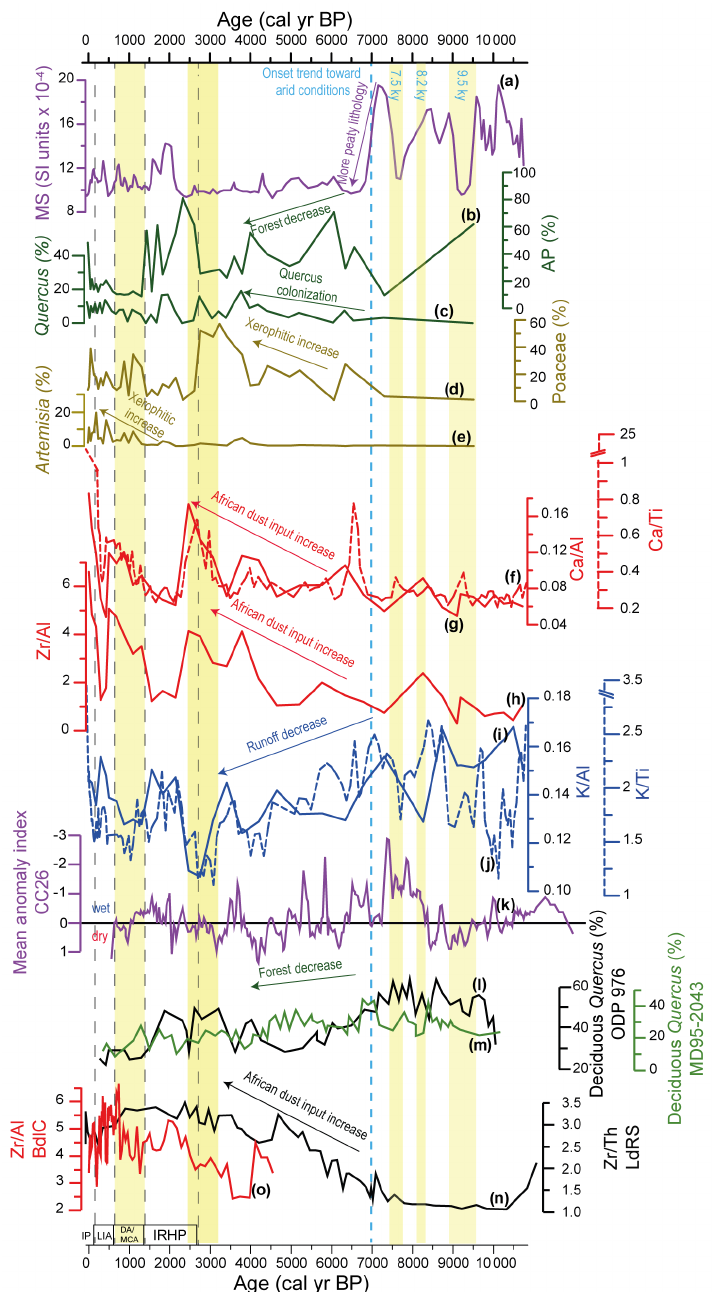
Figure 7. Comparison between the MS data (in SI units × 10 − 4 ), the most important pollen taxa and geochemical proxies from Laguna Hondera (LH) record, with nearby paleoclimate records. (a) LH magnetic susceptibility (MS) record; (b) arboreal pollen (AP) percentage from LH; (c) Quercus percentage from LH; (d) Poaceae percentage from LH; (e) Artemisia percentage from LH; (f) Ca / Ti (XRF) ratio from LH in dashed line; (g) Ca / Al ratio from LH; (h) Zr / Al ratio from LH; (i) K / Al ratio from LH; (j) K / Ti (XRF) ratio from LH in dashed line; (k) mean anomaly index from CC26 record (Corchia cave; Regattieri et al., 2014); (l) deciduous Quercus from ODP 976 record (Alboran Sea; Combourieu-Nebout et al., 2009); (m) deciduous Quercus from MD95-2043 record (Alboran Sea; Fletcher and Sanchez-Goñi, 2008); (n) Zr / Th ratio from Laguna de Río Seco (LdRS) (Jiménez-Espejo et al., 2014; García-Alix et al., 2018); (o) Zr / Al ratio from Borreguil de la Caldera (BdlC) (García-Alix et al., 2017; 2018). Yellow bands indicate more arid intervals. Dark dashed lines are used for separating the different current era periods: IRHP: Iberian Roman Humid Period; DA: Dark Ages; MCA: Medieval Climate Anomaly; LIA: Little Ice Age; IP: Industrial Period. Blue dashed line indicates the onset of the trend toward arid